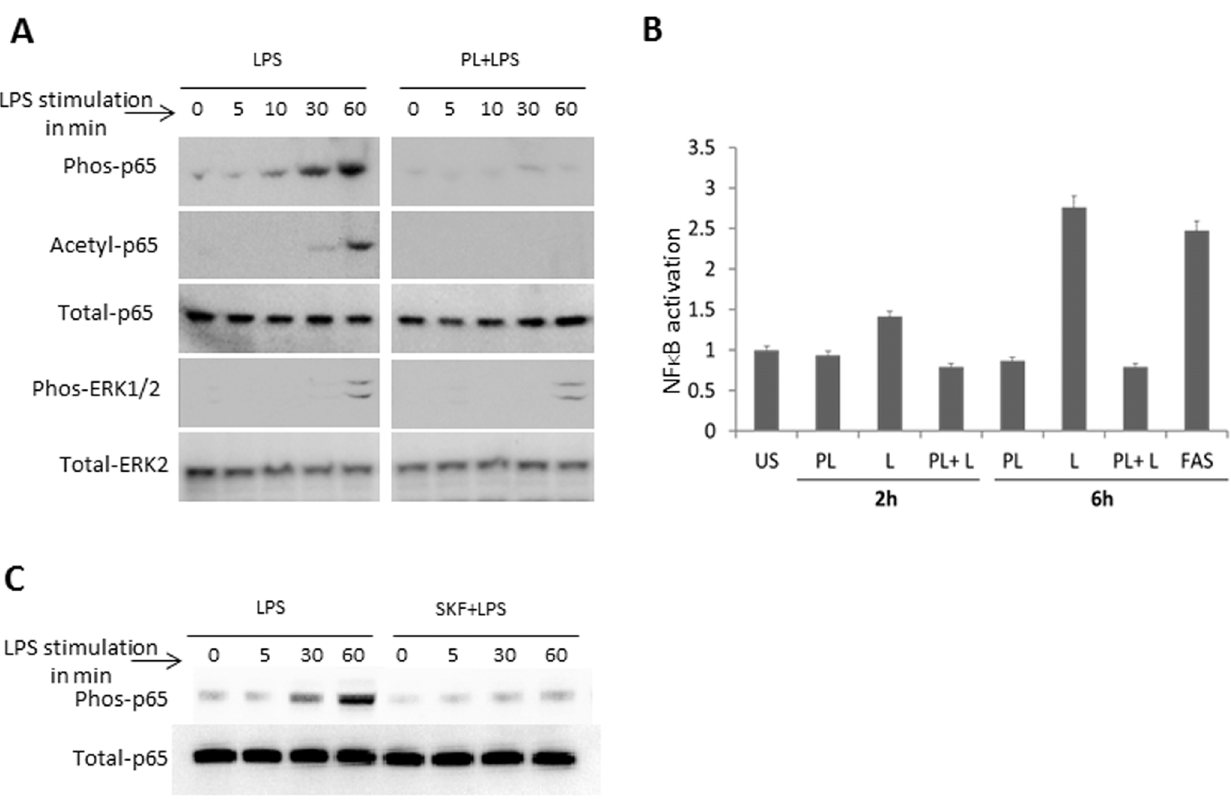
Figure 5. PL-mediated modulation in LPS-induced signaling. A) BMDMs were pulsed with medium alone or PL, LPS, PL + LPS. Extracts from BMDMs pulsed for mentioned period of time were electrophoretically separated, blotted and probed with Ab specific for phospho NF k B p65 (p65), p38, JNK, and ERK, or acetyl- NF k B p65, while anti- NF k B p65 anti-ERK as controls. Data shown here are representative of three independent experiments. B) Relative effects of PL, LPS, PL + LPS exposure on NF k B activation was measured in J774 macrophage cell line. FAS stimulation was used as a positive control. Data are normalized to luciferase activity in control J774 cells. Data indicates difference of values over their respective baseline control level in unstimulated (US) samples expressed in arbitrary units. C) BMDMs were pulsed with medium alone or LPS (10 ng/ml), SKF (10 m M) + LPS (10 ng/ml). Extracts from BMDMs pulsed for mentioned period of time were electrophoretically separated, blotted and probed with Ab specific for phospho NF k B p65 (p65), and ERK1/2, while anti- NF k B p65 anti-ERK as controls. Data shown here are representative of two independent experiments. Tg- induced STIM1 interaction with TRPC1 (Fig. 8). Together